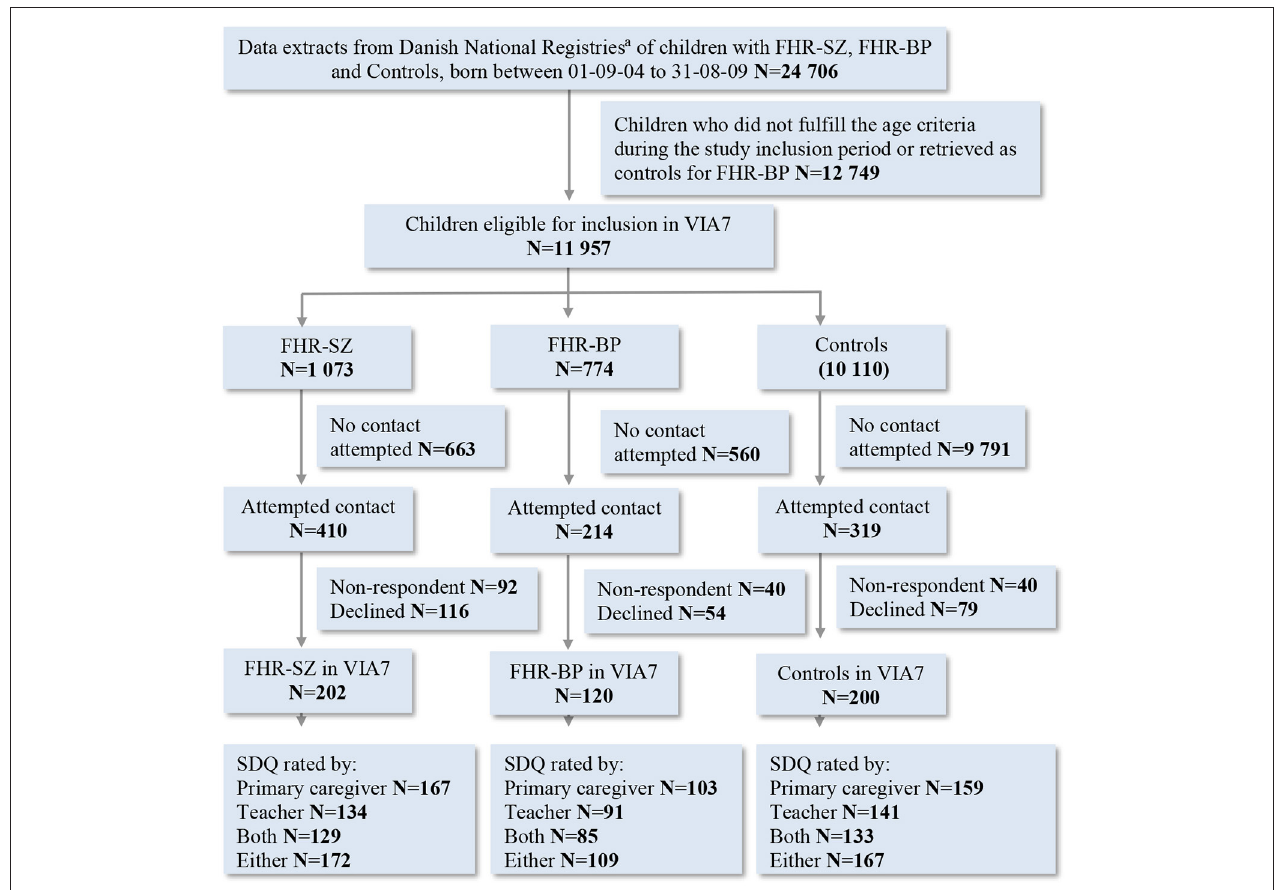
FIGURE 1 | Flowchart of the inclusion of children in the Danish High Risk and Resilience Study—VIA 7 and children contributing with SDQ data. SDQ, Strengths and Difficulties questionnaire; FHR-SZ, Children of parents with schizophrenia spectrum disorders; FHR-BP, Children of parents with bipolar disorder; PBC, Population-based control children of parents with no diagnoses of schizophrenia spectrum disorders or bipolar disorder. a Danish civil registration system and danish psychiatric central research